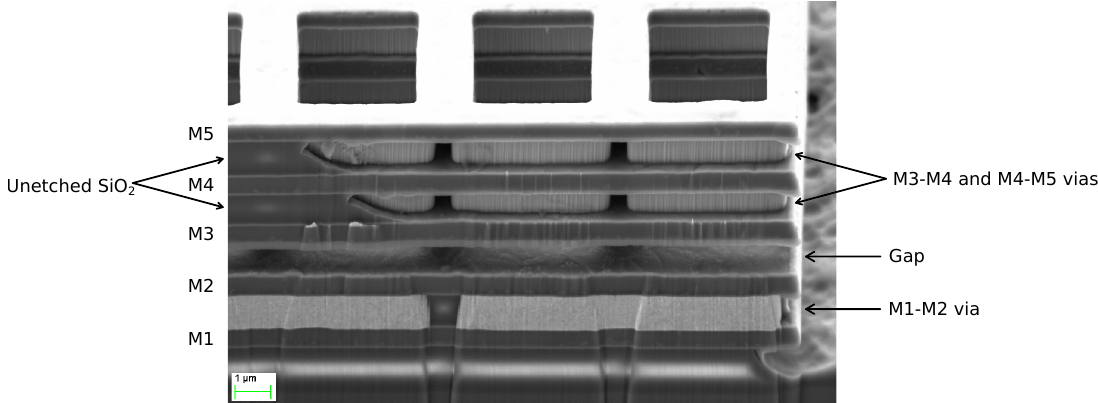
Figure 15. FIB cut of the device plate. The plate periphery is on the right. As it can be seen, acid penetration in between plate metal layers due to the absence of a blocking long via has etched away part of the SiO 2 . On the left, some oxide